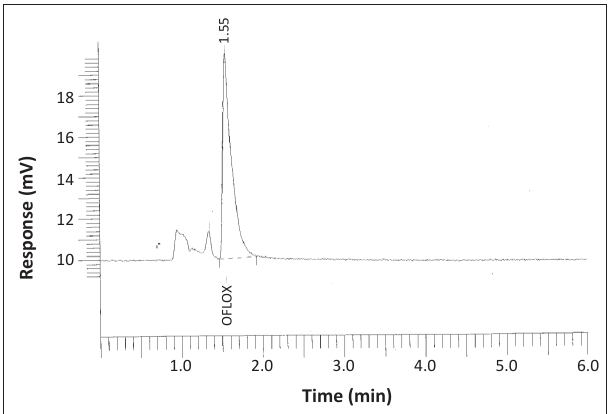
FIGURE 1: Chromatogram of extracted ofloxacin plasma standard (1.25 µ g. mL –1 ) with a retention time of 1.55